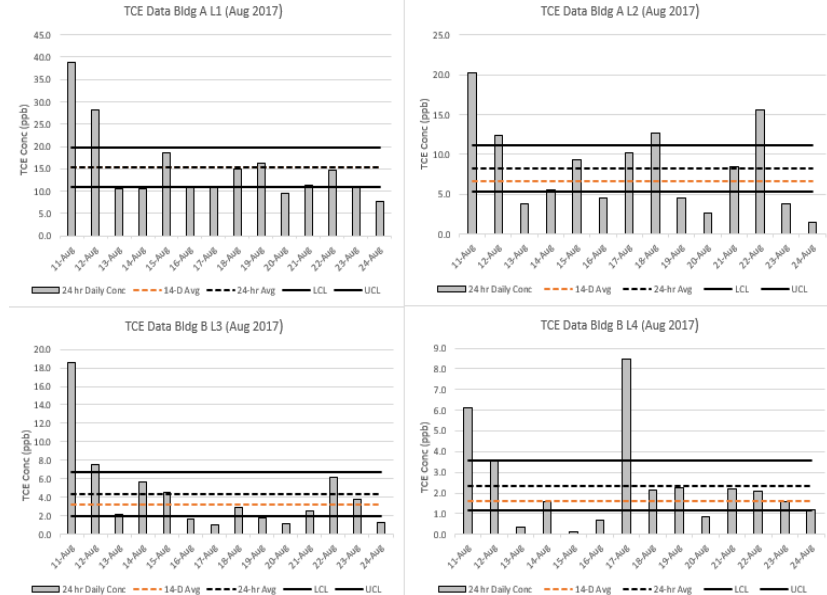
Figure 3. Comparative analysis of TCE concentrations from four locations (L1, L2, L3, L4) during a 2 wk period in August 2017 using traditional diaphragm (24 h) and capillary (14 d) controllers. Vertical gray bars represent daily concentrations, gray dashed lines represent the geometric mean (GM) of the daily (24 h) concentrations, solid black lines represent the 95% upper and lower confidence levels for the GM of the daily concentrations, and the orange dashed line represents the 14 d GM. Note: In the L1 plot, the two dashed lines are superimposed (the GMs are almost identical).